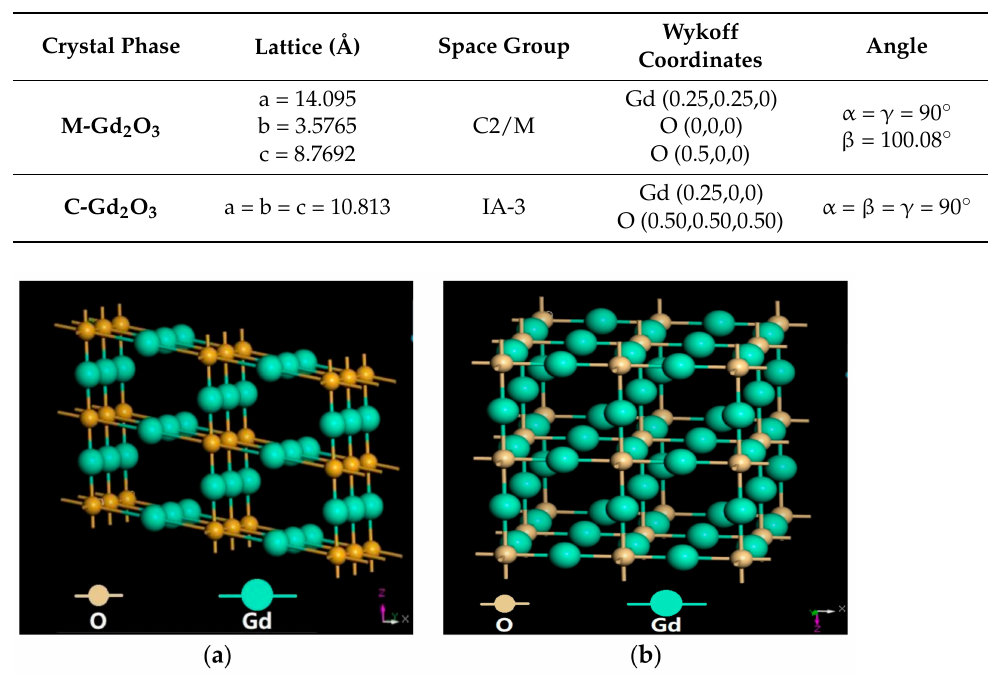
Table 7. Lattice parameters of the unit cells and the space group of the monoclinic and cubic Gd 2 O 3 .